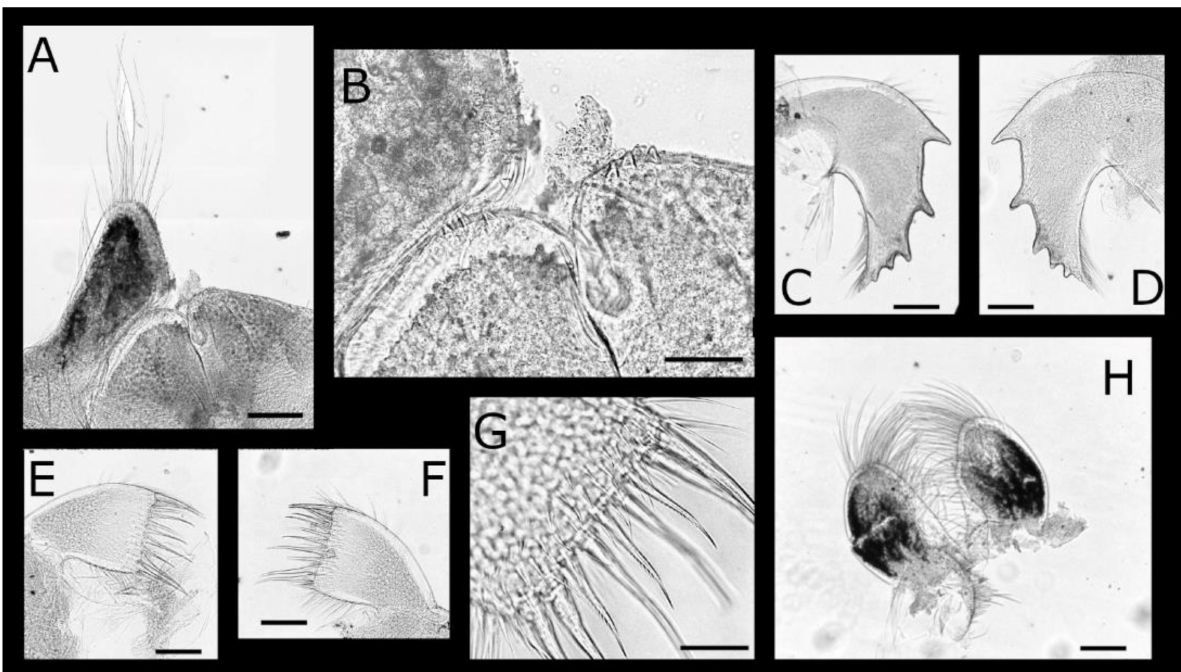
Figure 6. A casta fenestrata Darwin, 1854 mouth parts (all WAM C58749 except G, WAM C67829). ( A ) labrum and right mandibular palp; ( B ) close up of labrum crest; ( C , D ) left and right mandible; ( E , F ) left and right maxillule; ( G ) close up of setae on left maxillule; ( H ) left and right maxillae. Scale bars: A–B = 100 µ m; C–F, H = 200 µ m; G = 50 µ m.